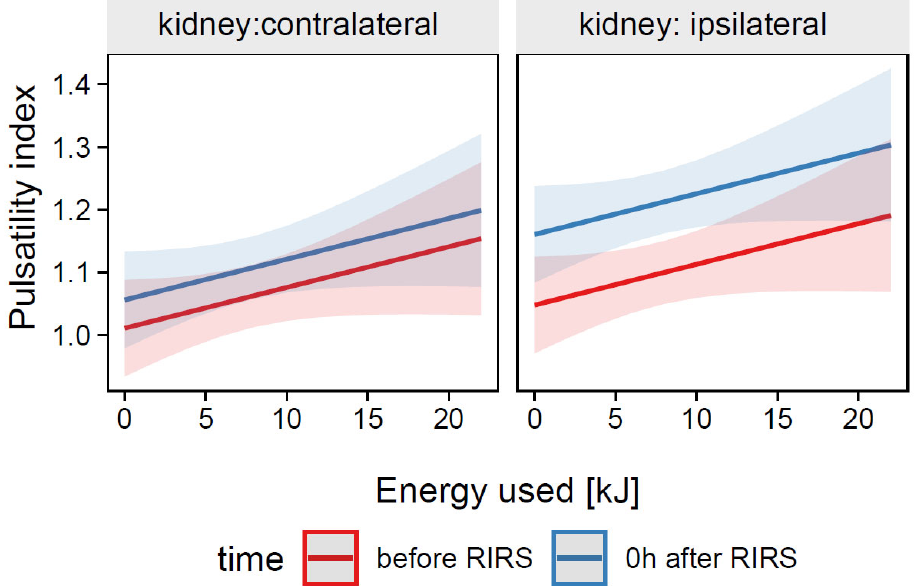
Figure 7. Predicted values (marginal effects) of pulsatility index by the Mod5 regression model for energy used, time and kidney side terms.